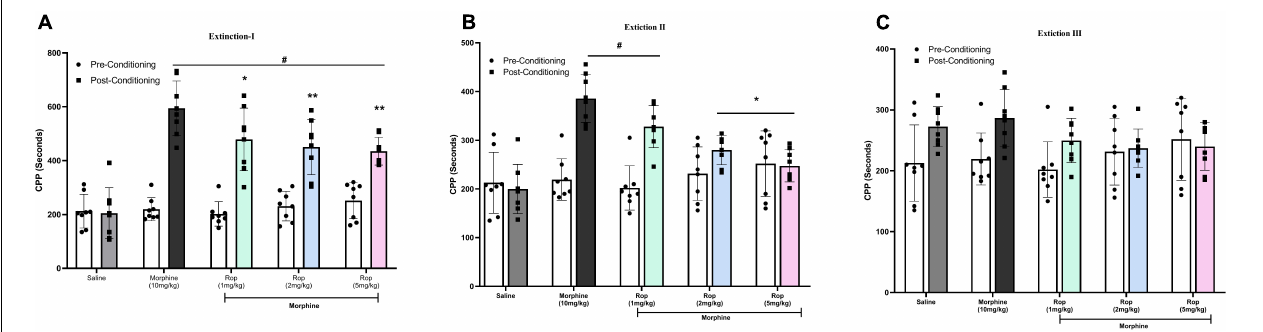
FIGURE 4 | The effect of ropinirole on extinction of morphine-induced CPP. Rats were injected with either saline/morphine (for saline and morphine control groups) or ropinirole (1, 2, and5 mg/kg) in periods of three days after the post-conditioning test. Data expressed as mean ± SD ( n = 8) (A) Extinction I (day 14), # p < 0.001 compared with saline post-conditioning group and * p < 0.05, ** p < 0.01 compared with the morphine post-conditioning group. (B) Extinction II (day 18), # p < 0.05 relative to the saline post-conditioning group and * p < 0.01 compared with the morphine post-conditioning group. (C) Extinction III (day 22) all the groups were non-significant. Ropinirole-Rop.